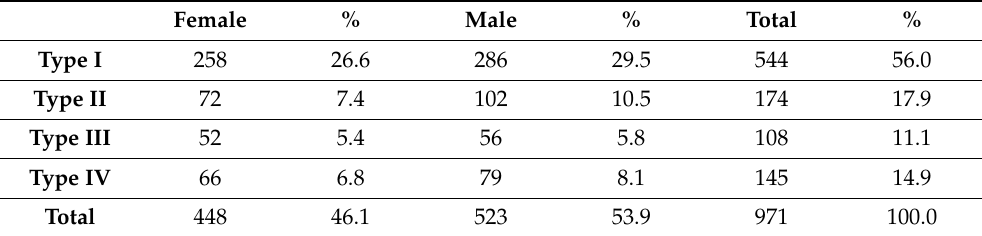
Table 2. Gender distribution according to the four fracture types classified by Von Laer.